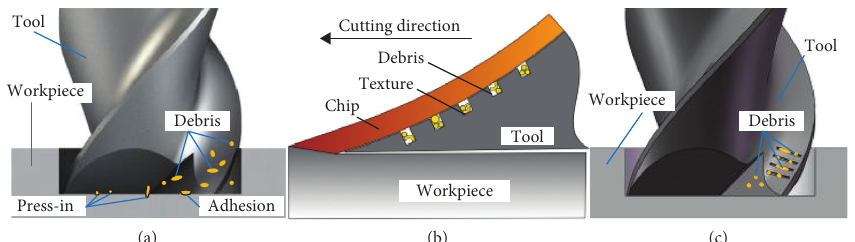
Figure 11: Schematic diagram of chip retention during milling. (a) Chips fall during milling and damage the machined surface, (b) the principle of texture storage debris, and (c) the use of texture tool reduces the falling of debris during